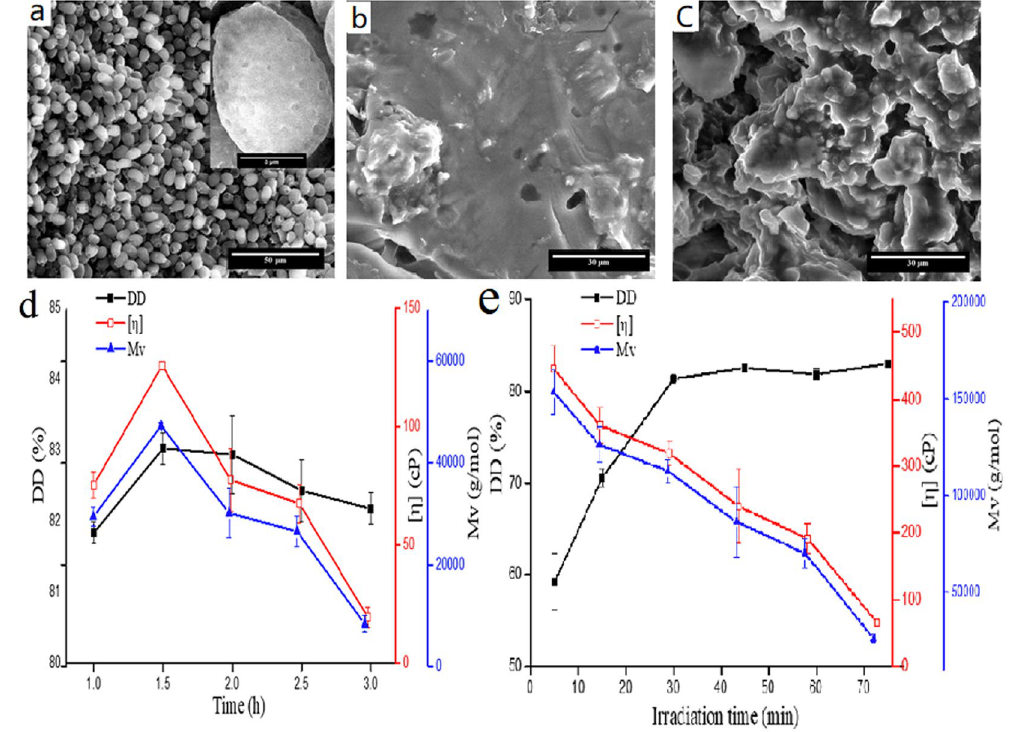
Figure 2. The effect of deacetylation and SEM images of GLSP, C-T and C-U ( a ) GLSP SEM ( b ) SEM of C-T ( c ) SEM of C-U, and the effect of deacetylation time on DD, [ η ] and Mv using TCD ( d ) and USAD ( e ). C-U sample was generated using USCD setup as: 90 W, 15 min, 20 w/v% NaOH, 1:15 (g: